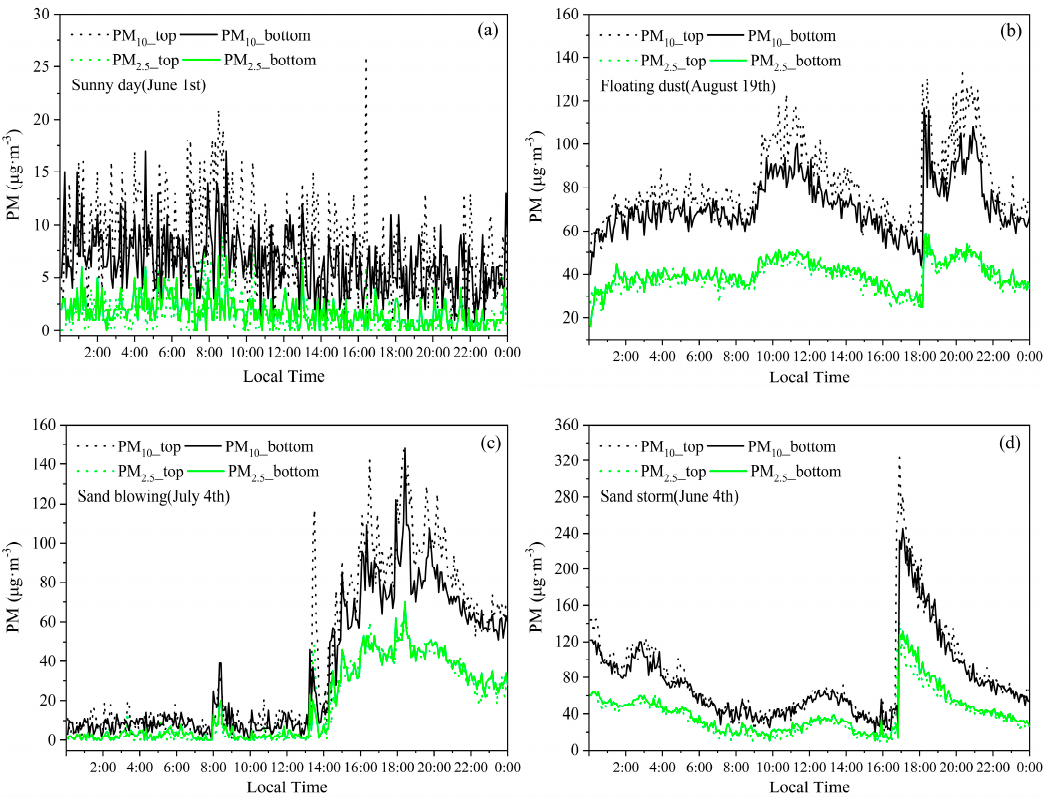
Figure 8. Diurnal variations in dust concentrations on the sunny ( a ), floating dust ( b ), sand blowing ( c ), and sandstorm days ( d ) in the TD.